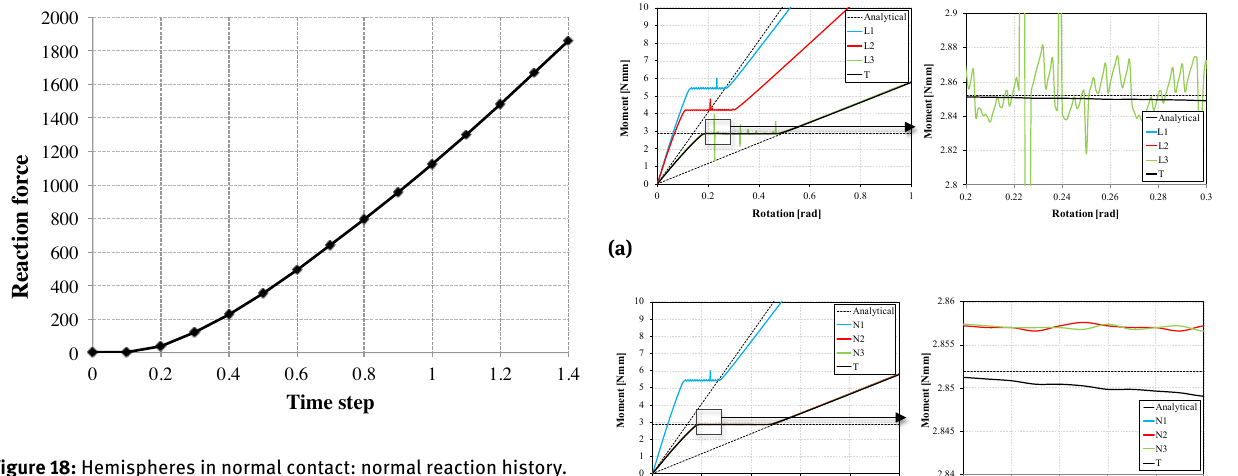
Figure 18: Hemispheres in normal contact: normal reaction history.